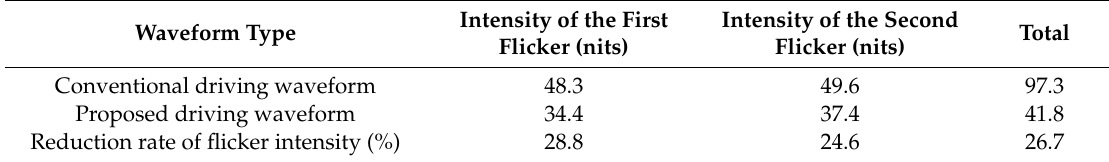
Table 3. The change in flicker intensity.